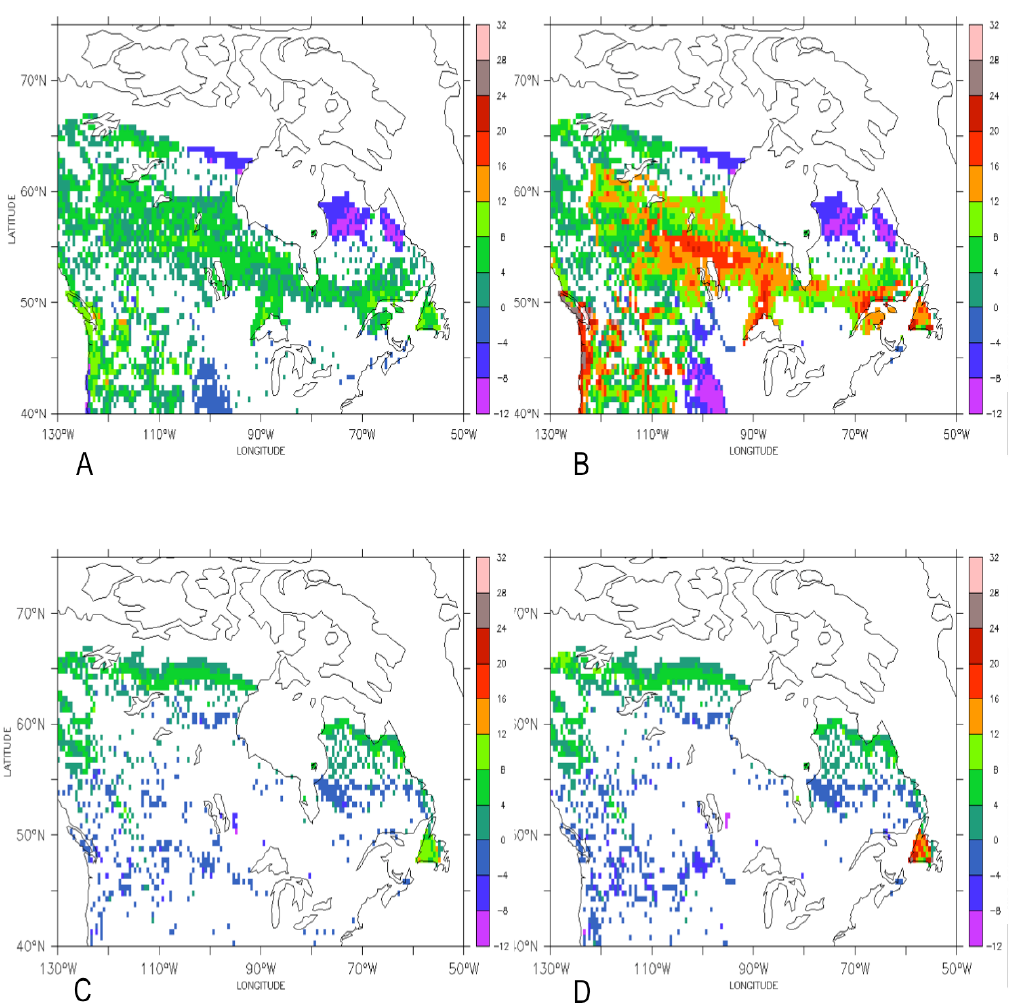
Figure 9. Maps after 100 simulation years of ( A ) total carbon di ff erence between the 10 km directed dispersal with standard disturbance scenario and the equilibrium response, and ( B ) the portion from the evergreen PFT. Until the deciduous species migrates, the evergreen PFT stored more carbon than the deciduous PFT. At simulation year 2000, both total carbon di ff erence ( C ) and the proportion from the evergreen PFT ( D ) were similar to the equilibrium response, except for the northern expansion of the forest extent (C and D, green).